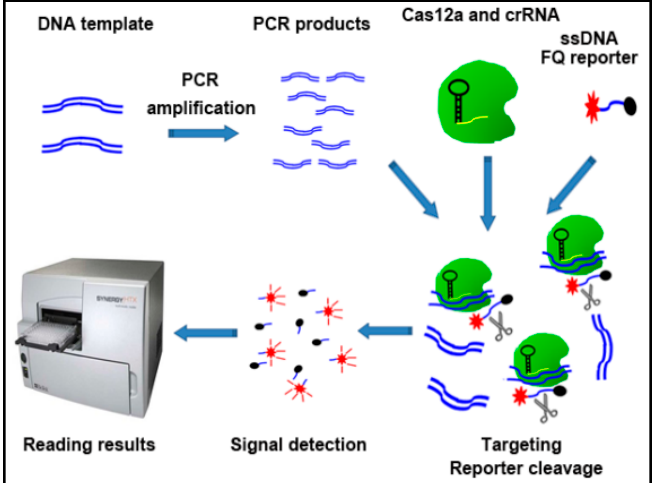
Figure 1. Overview of the CRISPR–Cas12a system to detect Kirsten rat sarcoma viral oncogene (KRAS) mutations. DNA was processed simply for PCR amplification. The PCR product was a mixture of LbaCas12a, crRNA, and ssDNA FQ reporter. Reaction was performed at room temperature on a plate reader for fluorescent readout.